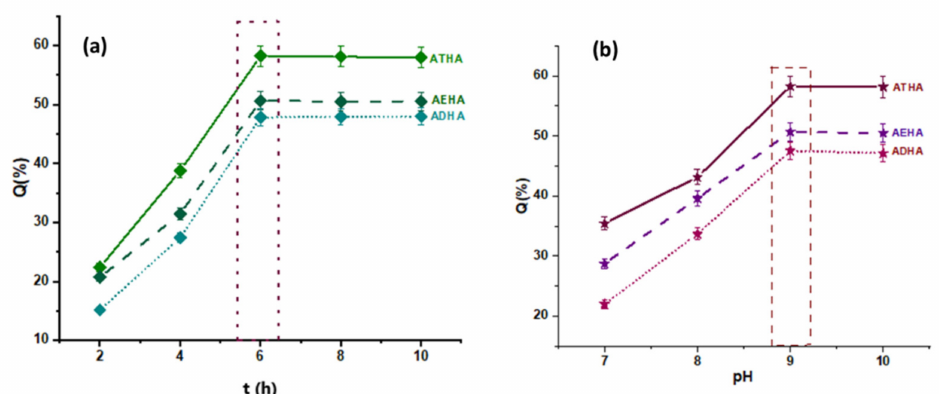
Figure 4. ( a ) The influence of the reaction time on the amount of grafted polymer (C P = 0.6%, T = 50 ◦ C, pH = 9); and ( b ) the influence of the pH of the HA solution on amount of grafted polymer (C P = 0.6%, T = 50 ◦ C, t = 6